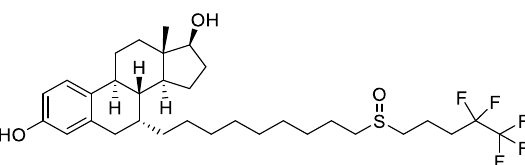
Figure 5. Structure of the selective estrogen receptor degrader (SERD) fulvestrant.